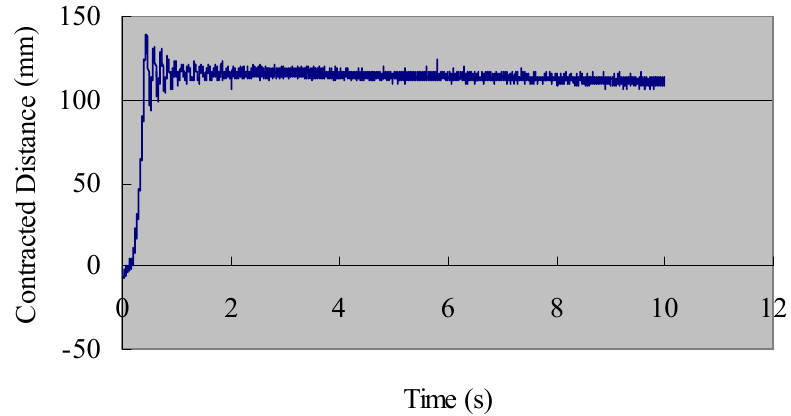
Figure 12. Deformation of the SMA actuator (30 g, 7